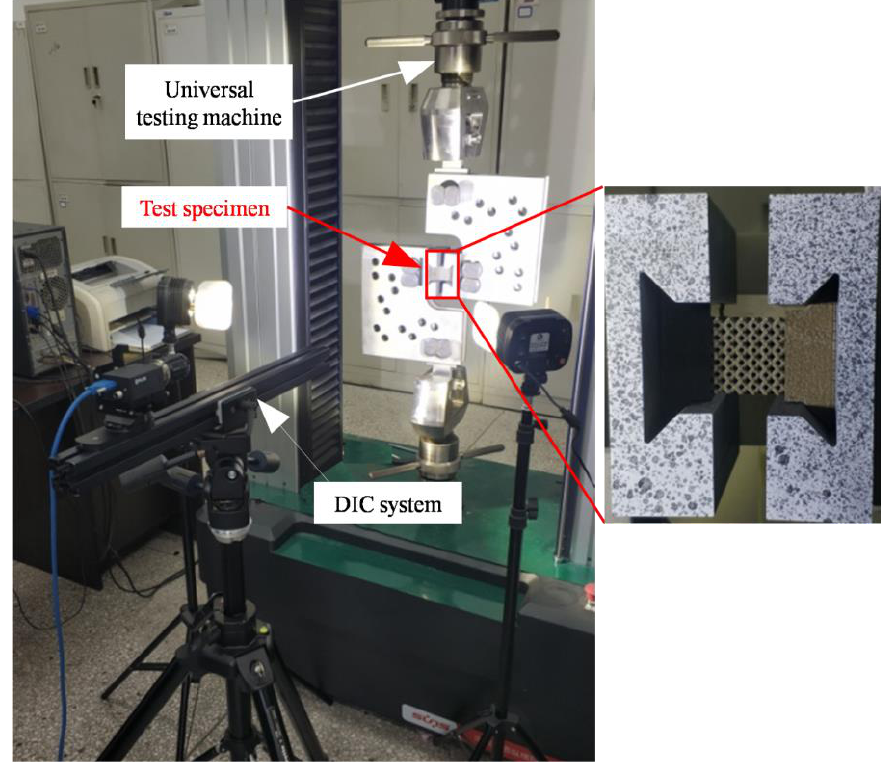
Figure 12. Loading process of test simple.